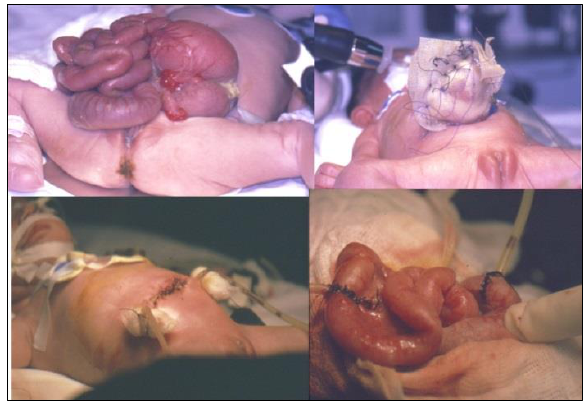
Figure 4: T-tube enterostomy in